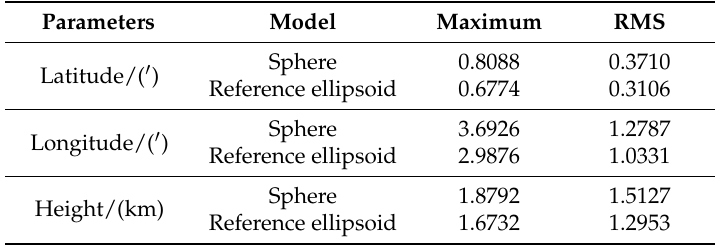
( b ) Figure 9. Navigation errors in high latitude regions: ( a ) grid SINS errors and integrated navigation errors; and ( b ) integrated navigation errors.